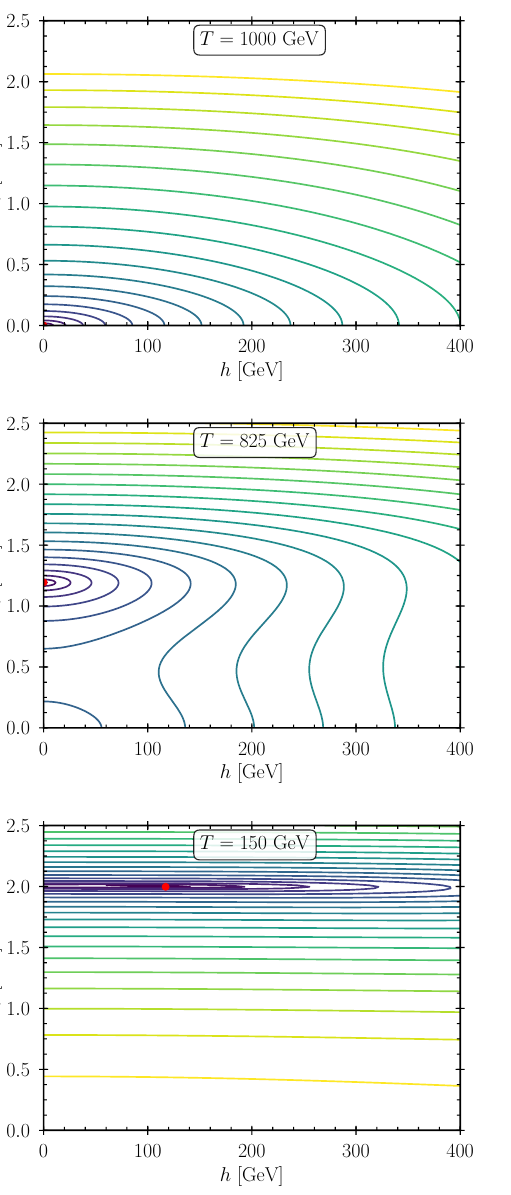
Figure 15 . E(cid:11)ective potential as a function of temperature. The colored equipotential lines correspond to V e(cid:11) = (30 GeV) 4 ; (60 GeV) 4 ; (90 GeV) 4 ; : : : ; (600 GeV) 4 (from dark purple to yellow). The red dot denotes the global minimum of the potential at V e(cid:11) = 0 GeV 4 . The model parameters are v (cid:8) = 2 TeV, m (cid:30) = 500 GeV, sin (cid:18) H = 0 : 05, m Z 0 = 1 : 5 TeV, (cid:15) = 0, m DM = 590 GeV, sin (cid:18) DM = 0, m e = m e = 650 GeV, and L 0 = 1 = 4 5 (cid:0)